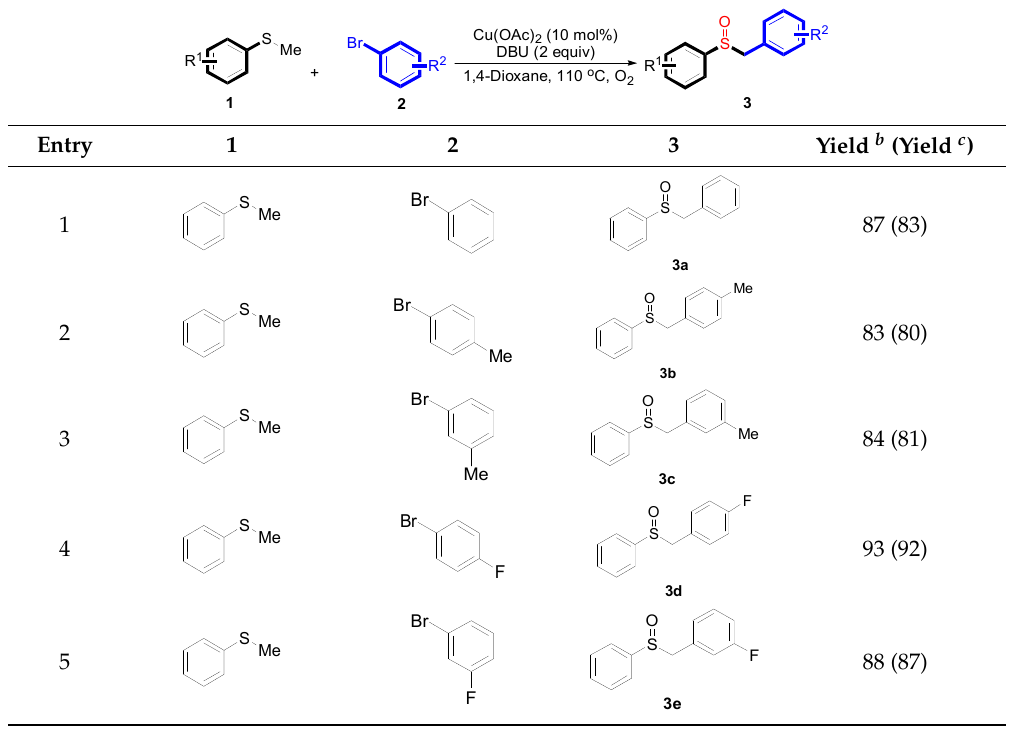
Table 2. Copper-catalyzed sulfoxidation of thioanisoles 1 with bromobenzenes 2 a .